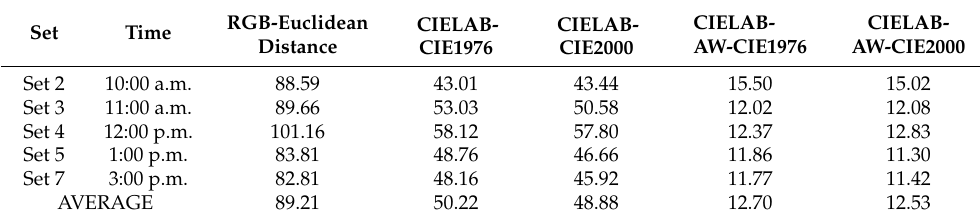
Table 2. Samsung Galaxy S 10 average prediction rank using RGB and CIELAB colour model and three distance functions—Euclidean distance, CIE1976, and CIE2000. AW—Proposed added weight difference from Table 4.